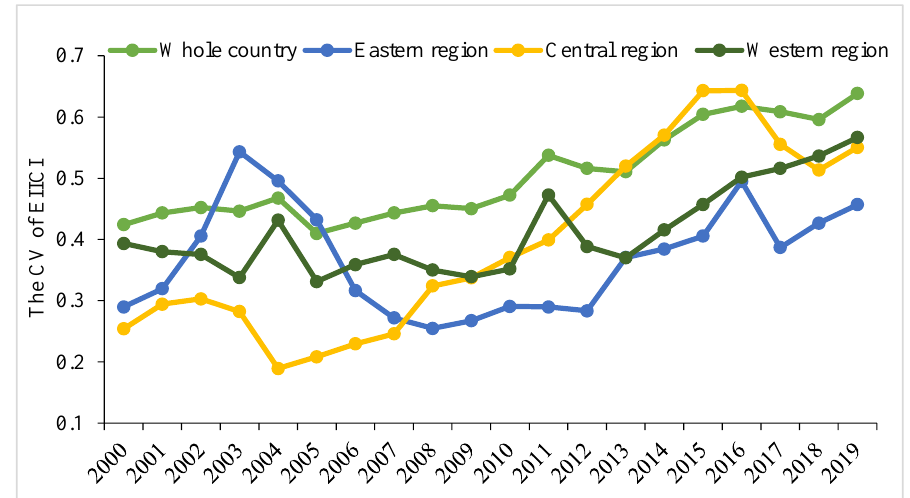
Figure 1. Variation coefficient of EIICI across the country and regions from 2000 to 2019.